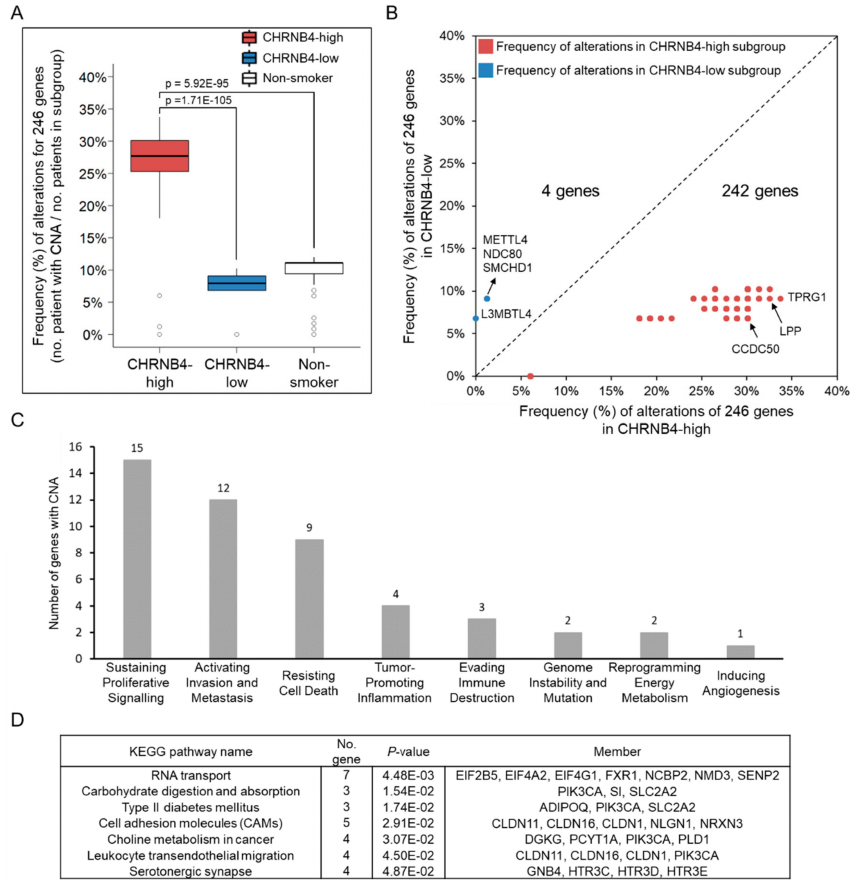
Figure 4. Copy number alterations (CNAs) between the CHRNB4-high and -low subgroups. ( A )